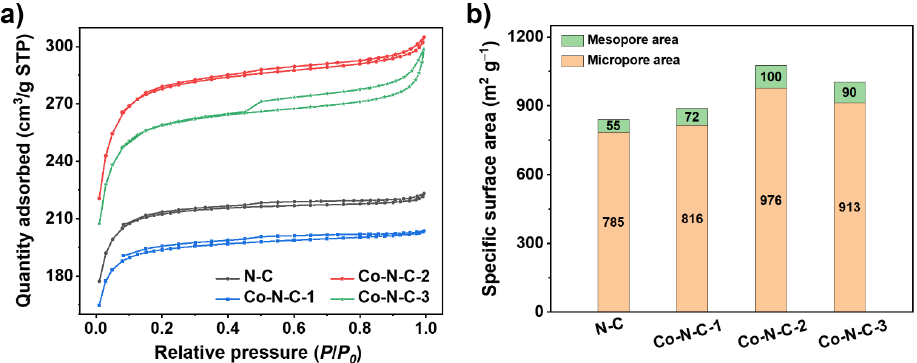
Figure 3. ( a ) Nitrogen adsorption–desorption isotherms of the N-C and Co-N-C catalysts; ( b ) spe- cific surface areas of the N-C and Co-N-C catalysts.